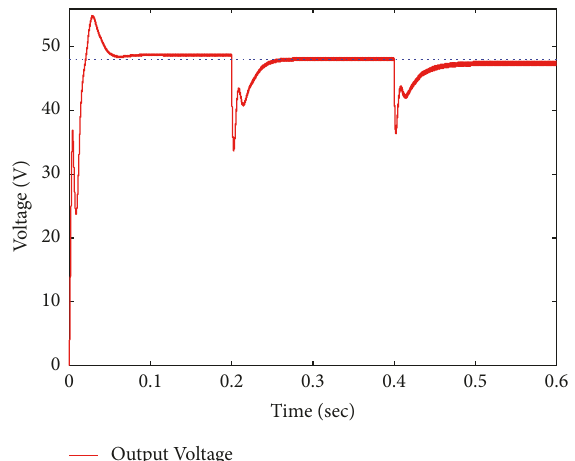
Figure 16: The output voltage at the common dc bus with 10% mismatch in the load regulation characteristics of the droop method.